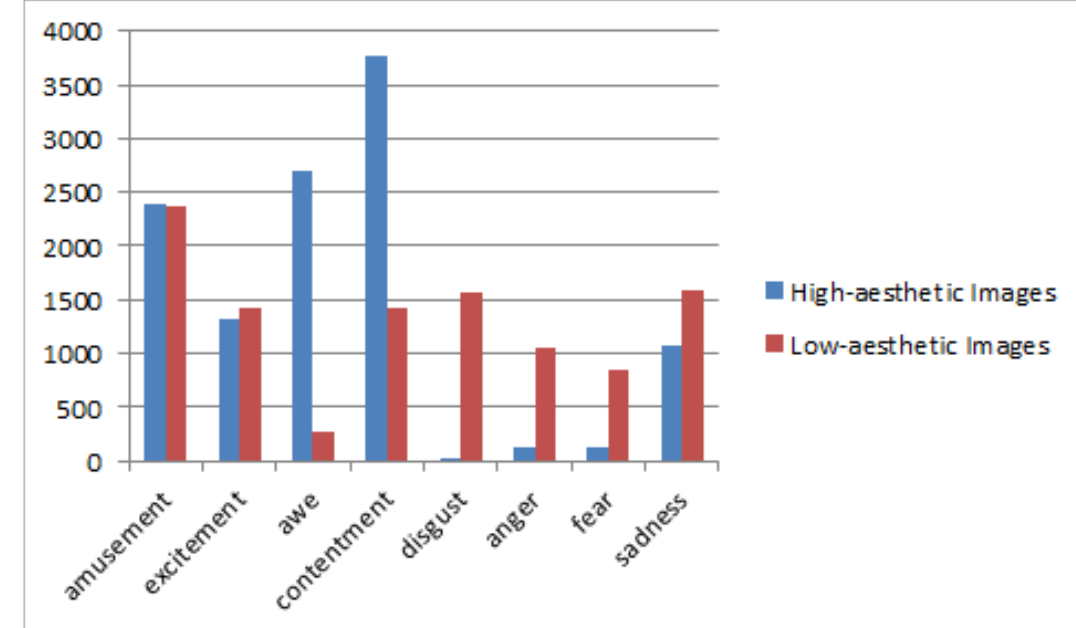
Figure 6. Data distribution in IAE dataset. The first four emotions (i.e., amusement, excitement, awe, and contentment) are positive, while the last four (i.e., disgust, anger, fear, and sadness) are